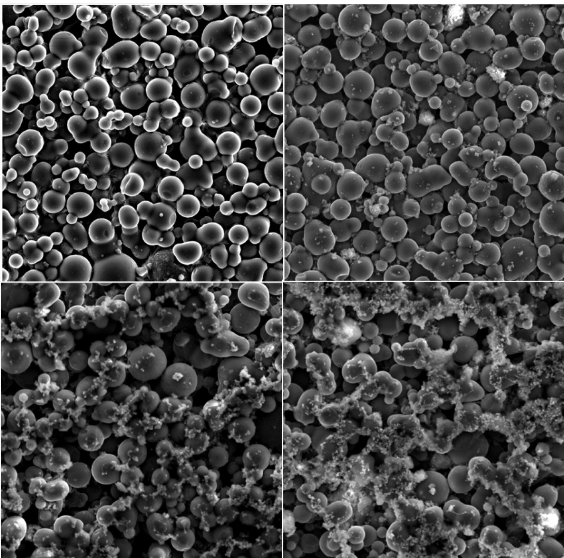
Fig. 5. Comparison of the SEM spectra for all produced foils. Magnification was x1000. Natural Carbon (Top Left), Purified with Oxides Removed (Top Right), Purified without Oxides Removed (Bottom Left), and Impure Carbon (Bottom